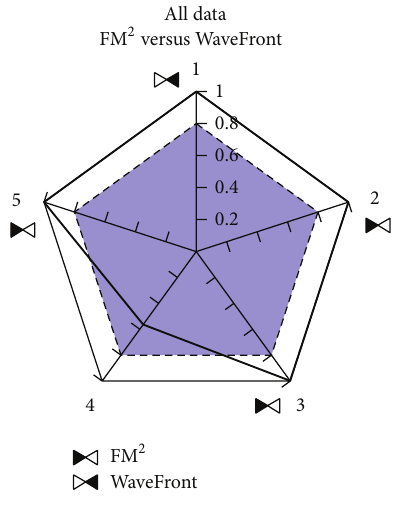
Figure 6: All data